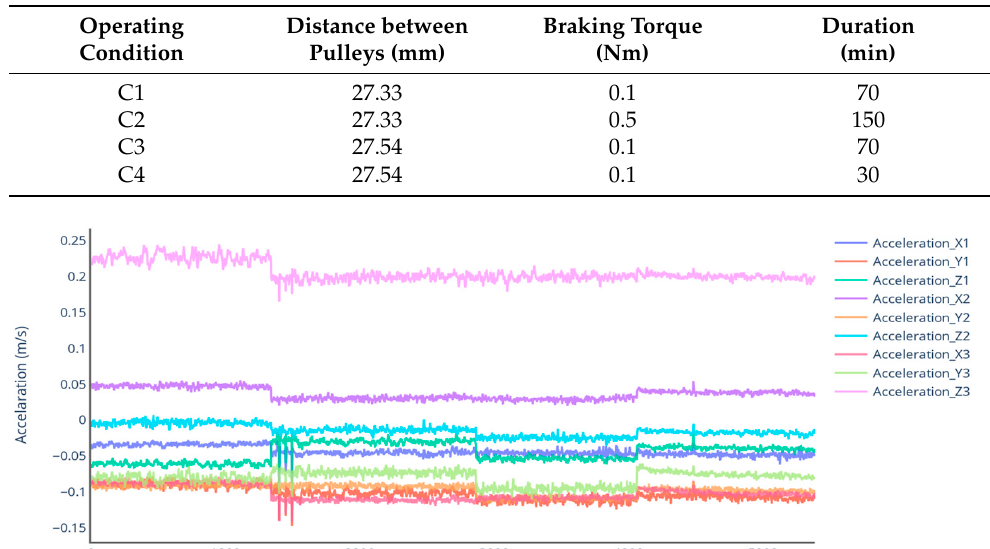
Figure 4. Raw signals from each operating condition (20 min per condition).